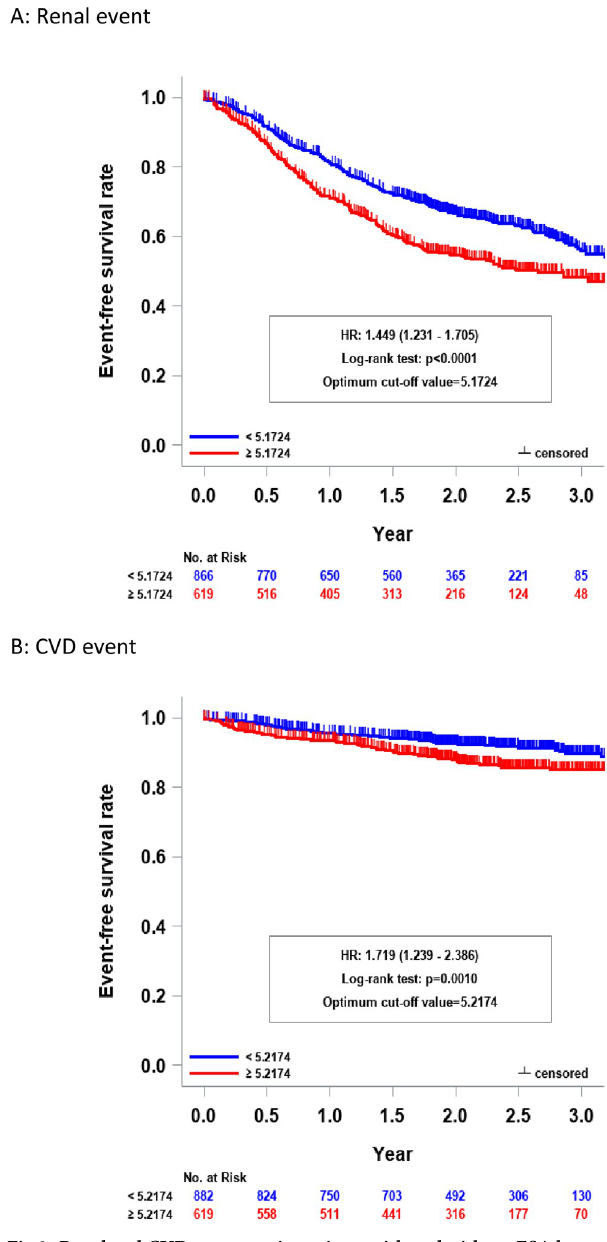
Fig 2. Renal and CVD outcomes in patients with and without ESA hyporesponsiveness. A, Renal survival was significantly worse in patients with high ESA hyporesponsive index (ERI-1B � 5.1724) than in those with lower ERI-1B (log-rank test; P < 0.0001). B, Event-free survival for CVD was significantly lower in patients with high ERI-1B ( � 5.2174) than in those with low ERI-1B (log-rank test; P = 0.0010). ESA, erythropoiesis-stimulating agents; CVD, cardiovascular